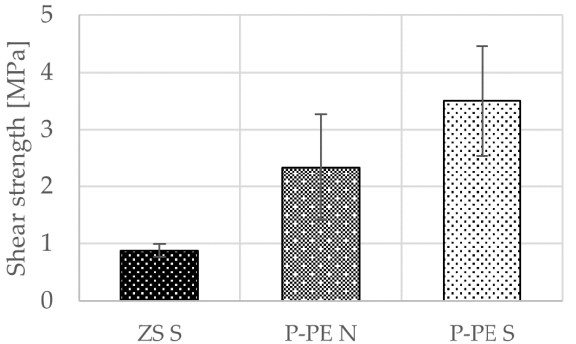
Figure 8. Strength of samples prepared from nontreated polymer (ZS), plasma-treated polymer without the sintering step (P-PE N) and from plasma-treated polymer with the sintering step (P-PE S).